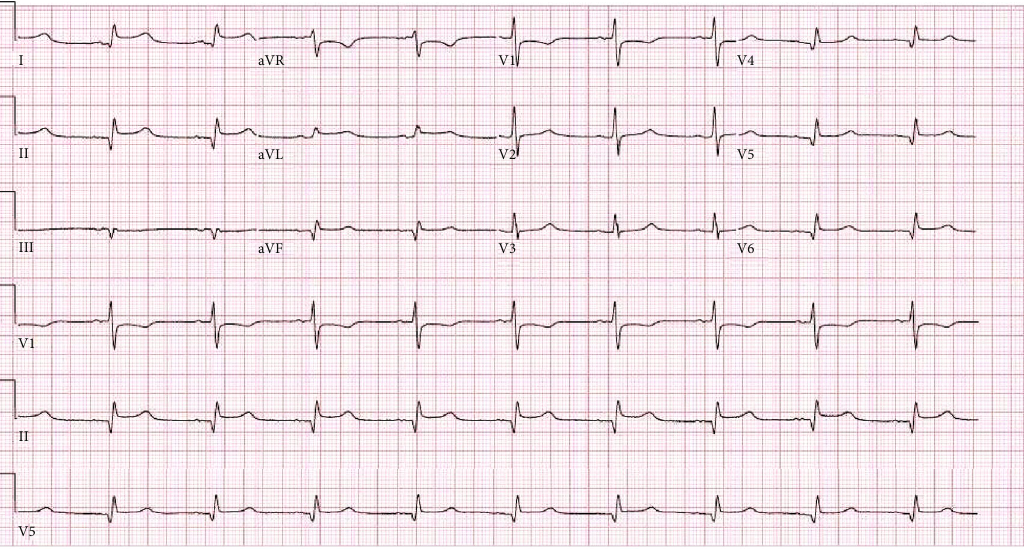
Figure 2: EKG on hospital day 7 with enlarging pericardial e ff usion. Normal sinus rhythm with new 2mm ST elevations in leads I and II,